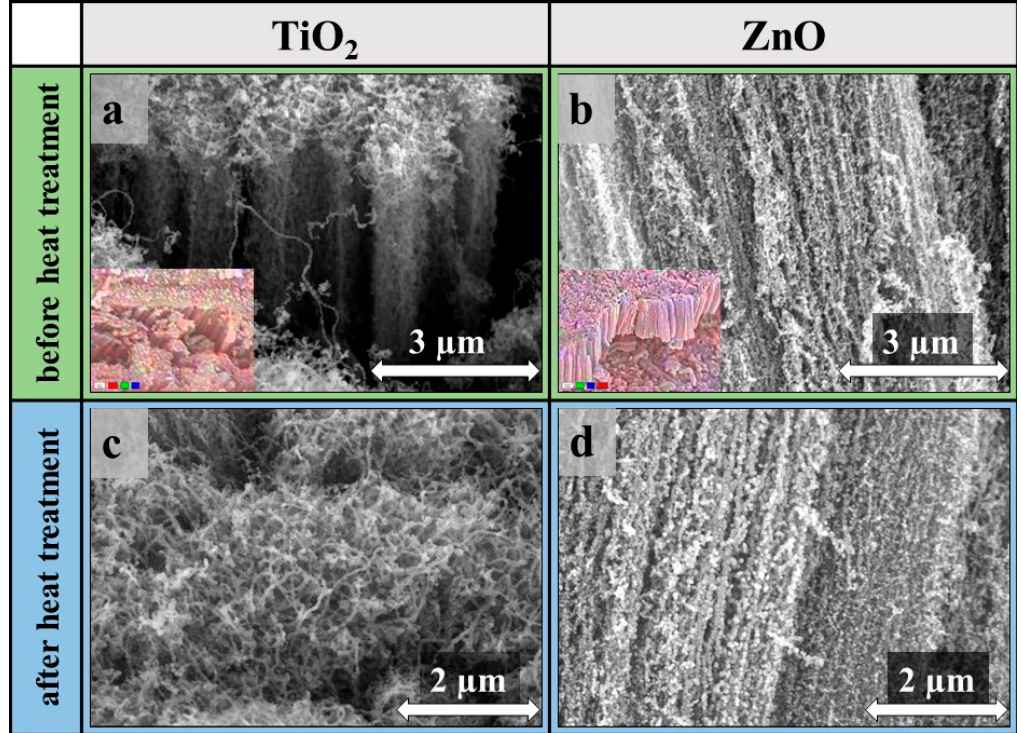
Figure 3. SEM images of TiO 2 ( a , c ) and ZnO ( b , d ) coated CNT forests before ( a , b ) and after ( c , d ) heat treatment, element mapping of CNT forest composites (inset ( a )–red: Ti, green: C, blue: O; inset ( b )–red: Zn, green: C, blue: O). Table 1. Composition of the samples from EDX spectra (b.HT: Before heat treatment; a.HT: After heat treatment).